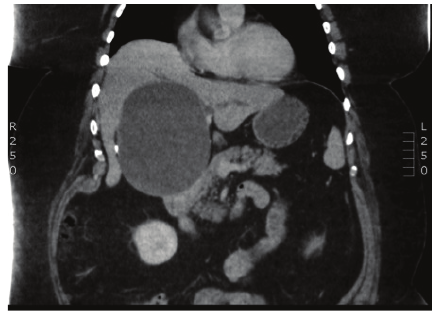
Figure 1: CT scan showing unilocular biliary cystadenoma without any septations but with calcification in the wall.